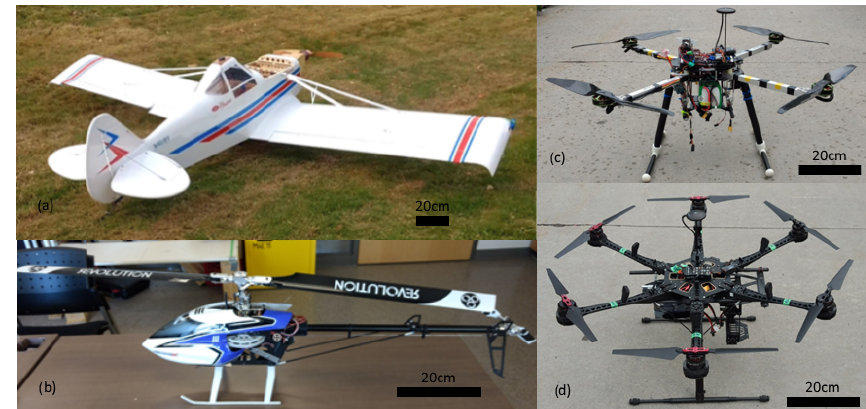
Figure 1. Photographs of the UAS investigated in this study: (a) single-motor fixed-wing, (b) single-rotor helicopter, (c) quad-rotor helicopter, and (d) hexa-rotor helicopter.